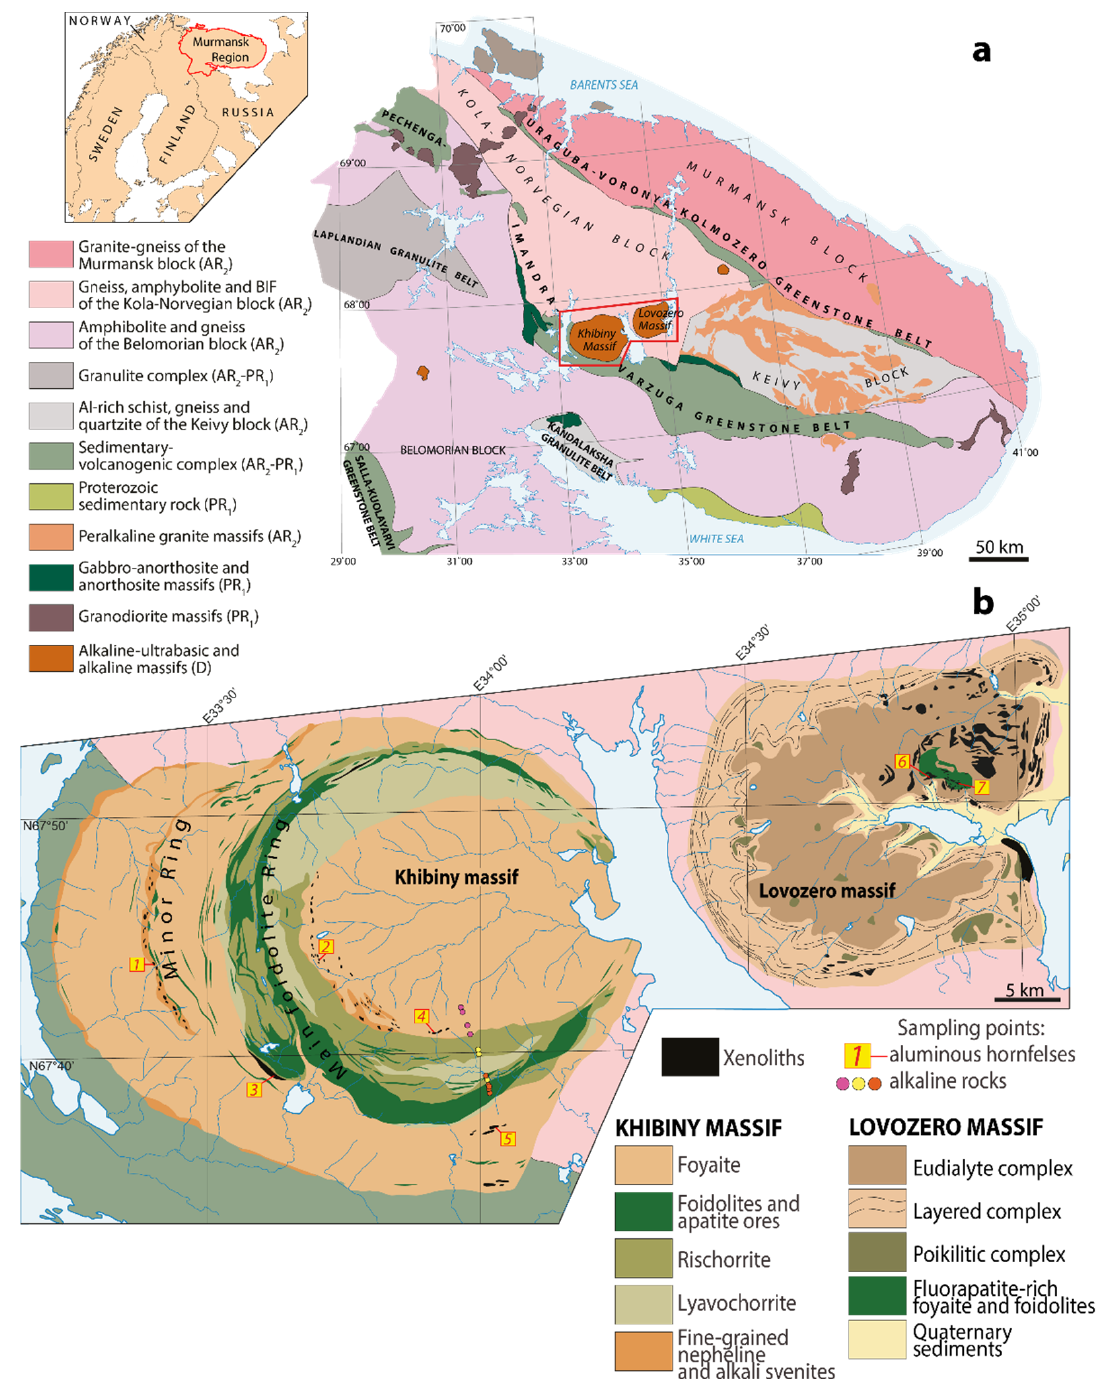
Figure 1. ( a ) Simplified geological map of the Murmansk Region [26]; ( b ) geological schemes of the Khibiny and Lovozero massifs [27,28].